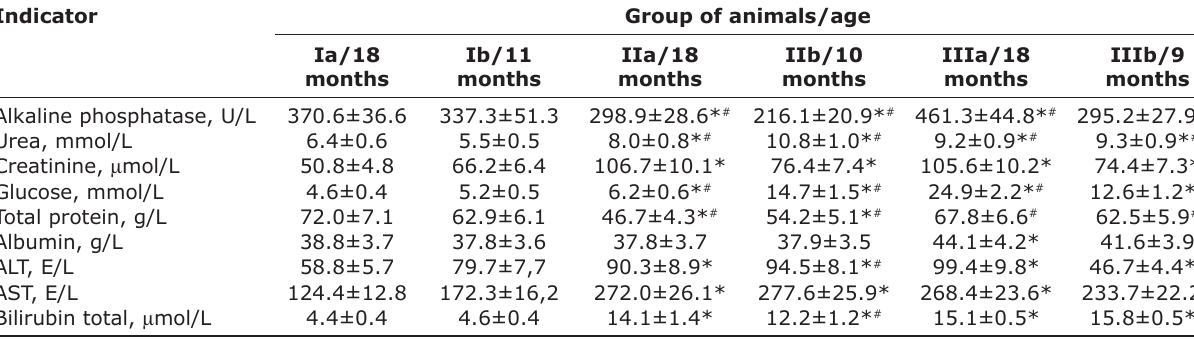
Table-8: Biochemical indices of rat blood (experiment of 12 months).